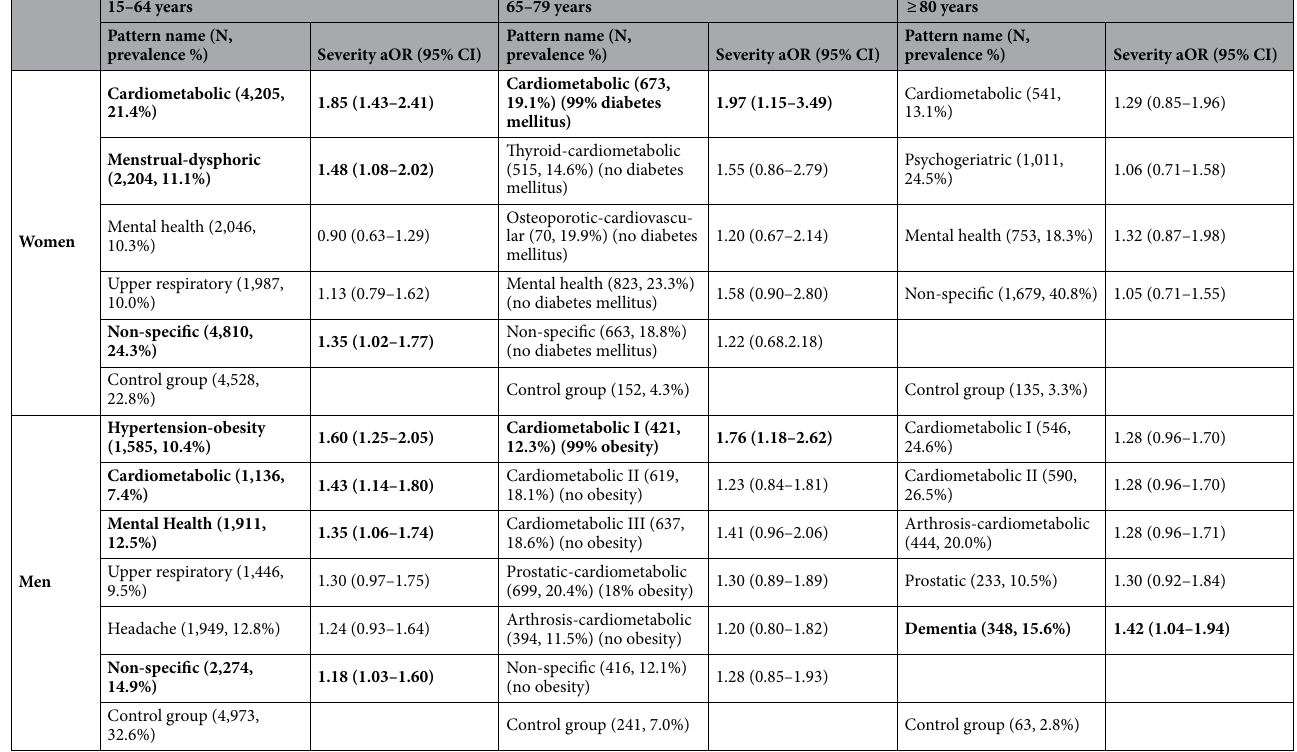
Table 2. Denomination and prevalence of multimorbidity patterns found in COVID-19 patients based on sex and age and their age-adjusted odds ratios (aOR) of infection severity compared with chronic patients